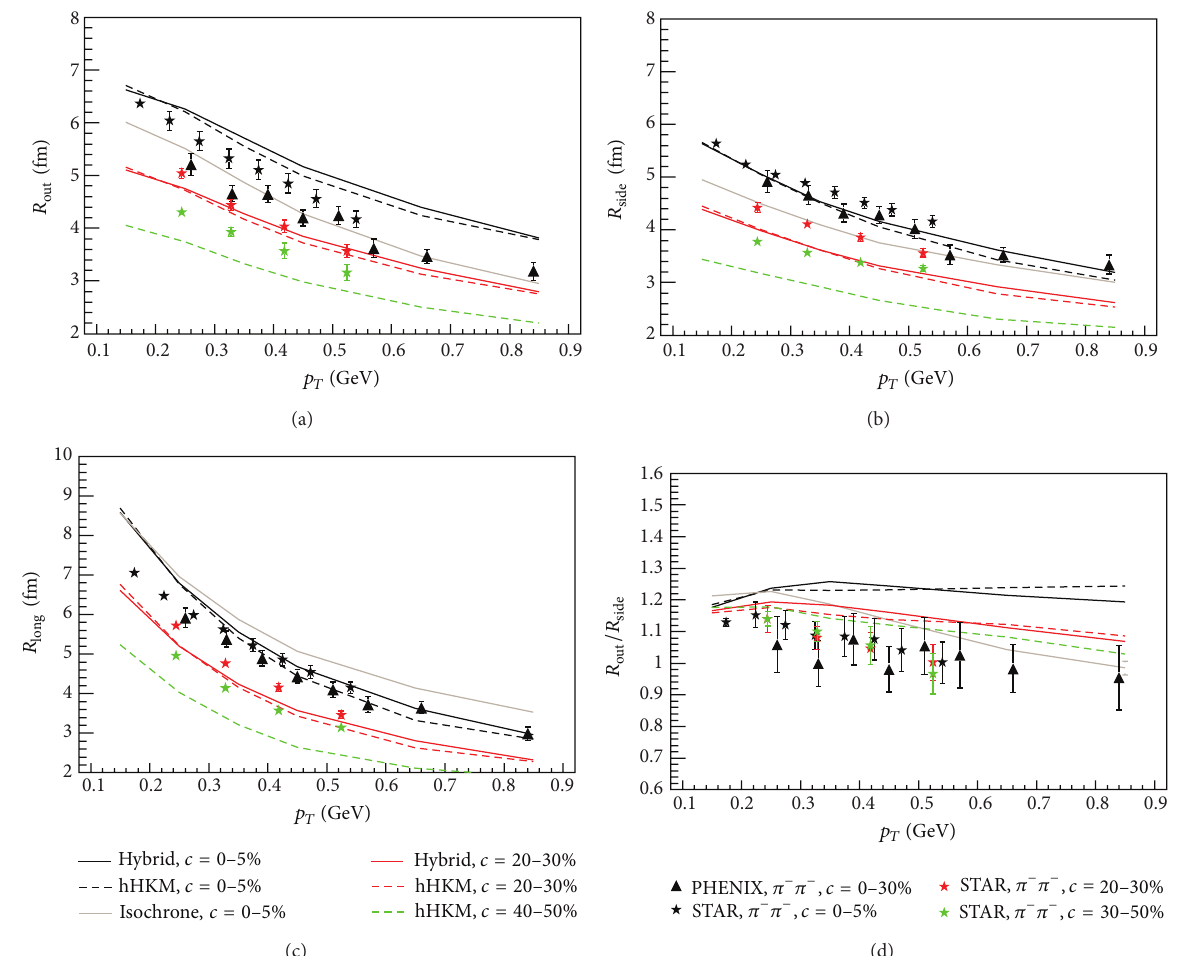
Figure 2: HBT radii of 𝜋 − pairs at 200 AGeV RHIC energy, calculated in different models and compared to experimental data from the STAR [69] and PHENIX [70] collaborations. Dashed lines correspond to the hydrokinetic procedure of matching (hHKM), while solid lines stand for the “hybrid” model case. The results for the “hybrid-isochronic” model are presented for central 𝑐 = 0–5% events with a gray solid line. The ICs used for hydrodynamic evolution: 𝜏 0 = 0.1 fm/c with zero initial transverse flow and the MC-Glauber profiles for initial entropy